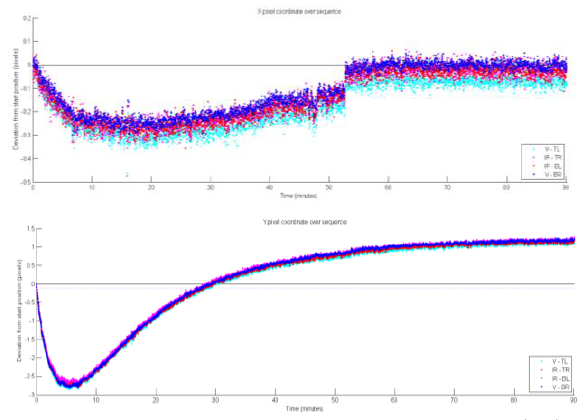
Figure 11. Differences from initial centroid positions: (top) x coordinate, (bottom) y